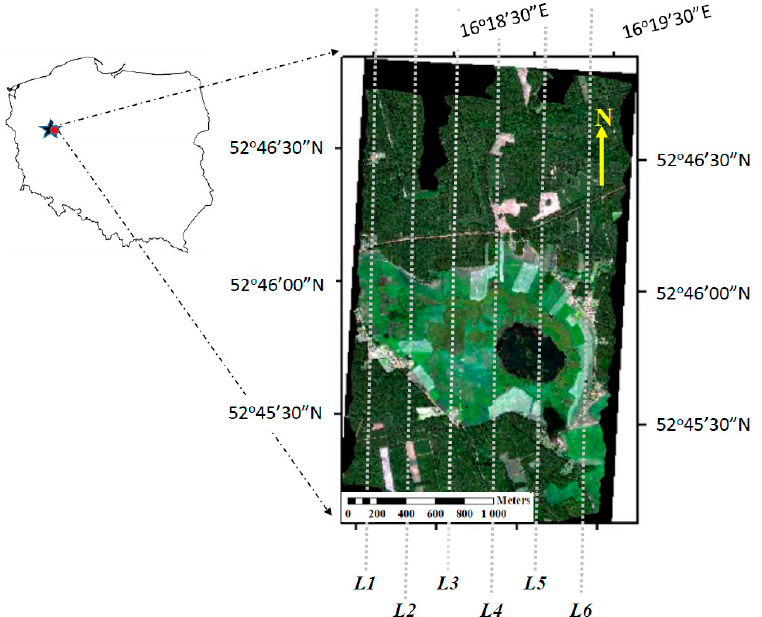
Figure 1. Location of the Rzecin peatland experimental site in the Wielkopolska region, Poland. An RGB composite map was obtained by combining reflectance bands at 156 nm, 105 nm, and 51 nm for the red, green, and blue bands, respectively—including flight lines of the HyPlant over the site during the Spectrometry of a Wetland and Modelling of Photosynthesis (SWAMP) campaign on 11 July